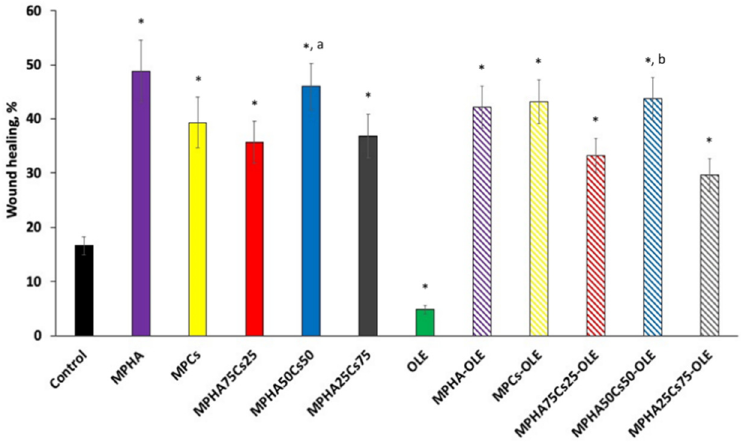
Figure 9. Wound closure rates expressed as percentage of scratch closure after 24 h compared to initial area. Control consists in untreated cells. Means ± SD ( n = 6). * p < 0.05 vs. control; a p < 0.5 vs. MPHA75Cs25 and MPHA25Cs75; b p < 0.5 vs. MPHA75Cs25-OLE and MPHA25Cs75-OLE.